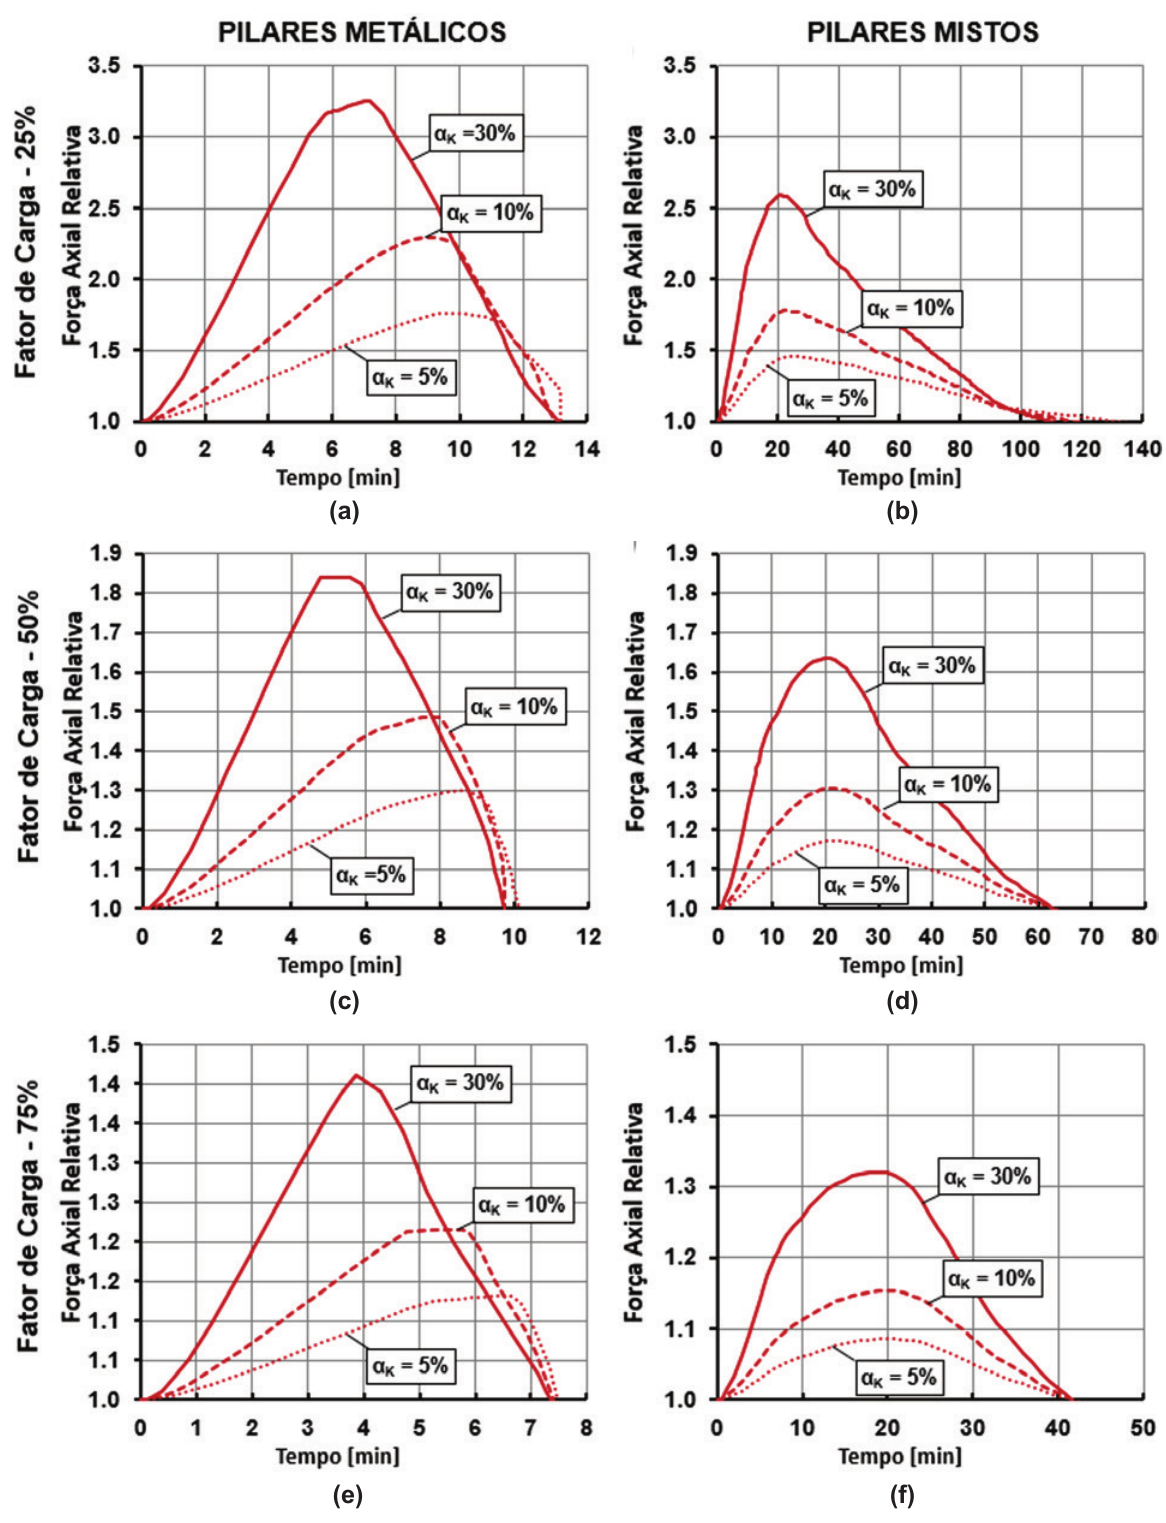
Figura 9 Influência da variação da rigidez axial da estrutura circundante no desenvolvimento das forças axiais relativas para os pilares de aço e